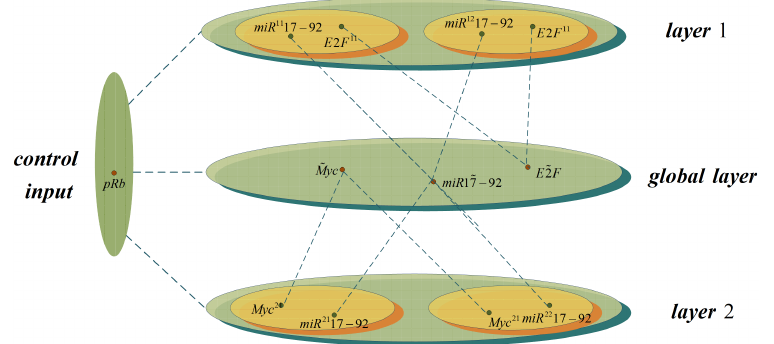
Figure 4. The PBMCNs structure of the cell cycle of